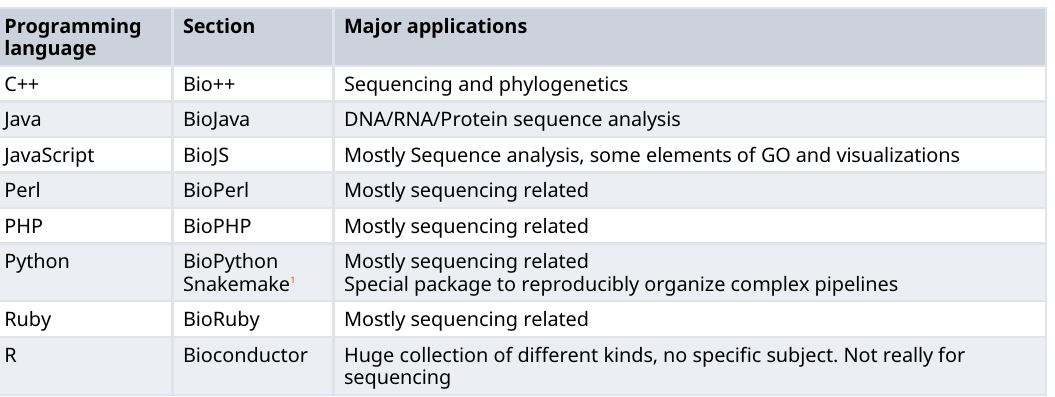
Table 1. Programming languages supporting biological packages, their names and major